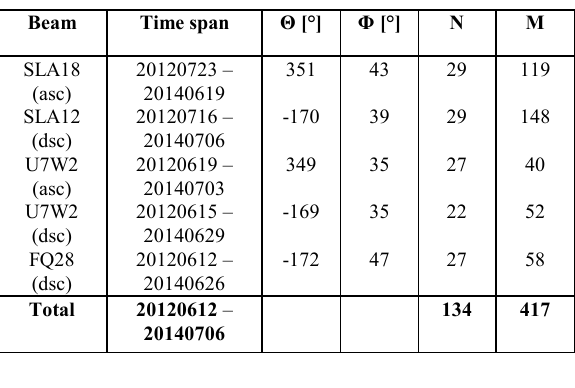
Table 1. RADARSAT-2 dataset used in the study: beam, time sp an (in format YYYYMMDD), azimuth (Θ), incidence angle (Φ), number of available SAR images (N) and number of produced interferograms